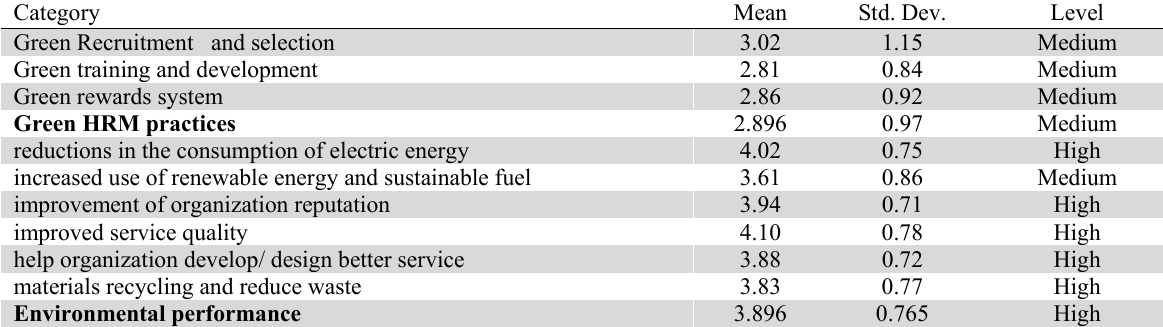
The mean and standard deviation for the survey items in Jordanian hospitals